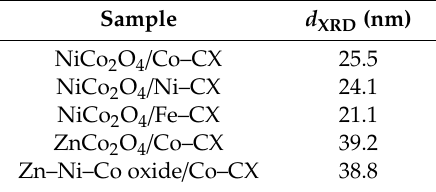
Table 2. Mean particle size obtained from applying the Scherrer equation to XRD patterns.